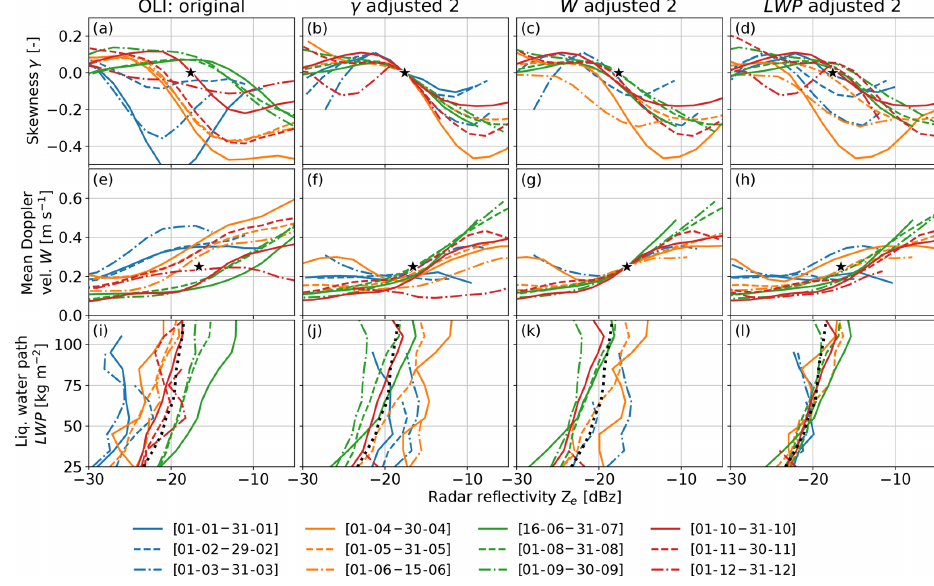
Figure 8. As in Fig. 6 but considering a calibration offset for the phase classification.